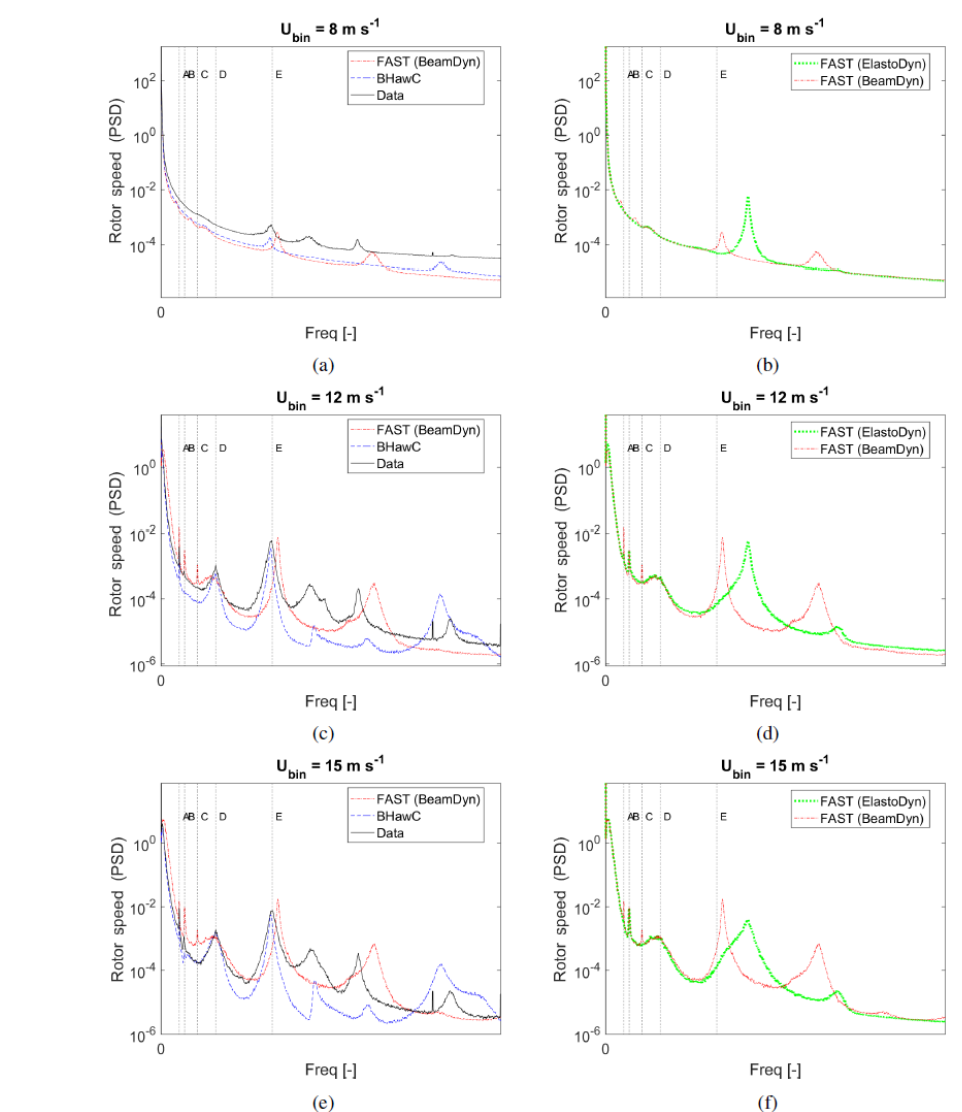
Figure 13. PSDs of the rotor speed. The three sets of graphs represent the ensemble-averaged PSDs from the inflow velocity bins at 8ms − 1 (top), 12ms − 1 (center), and 15ms − 1